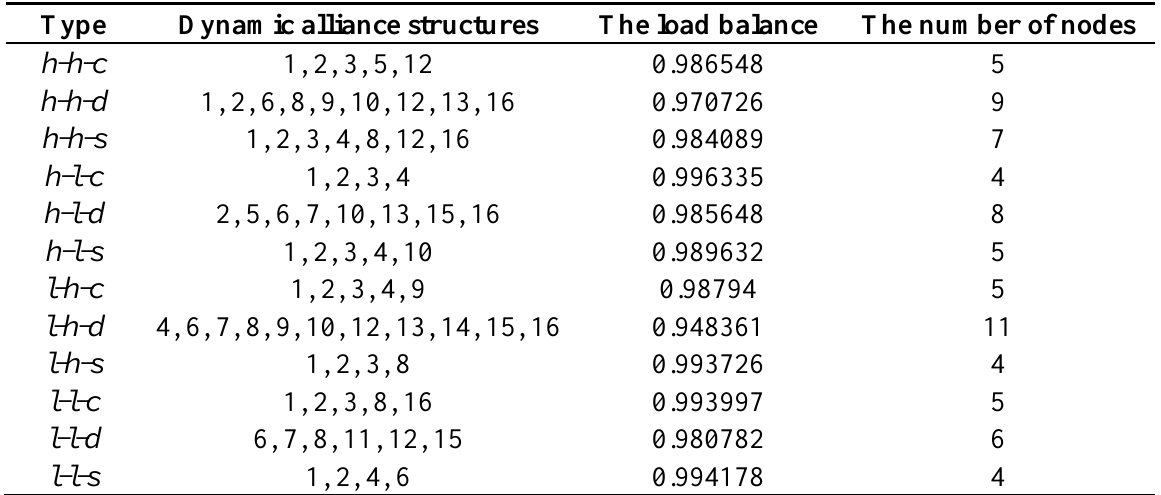
Table 1. The result of DPSO-DA